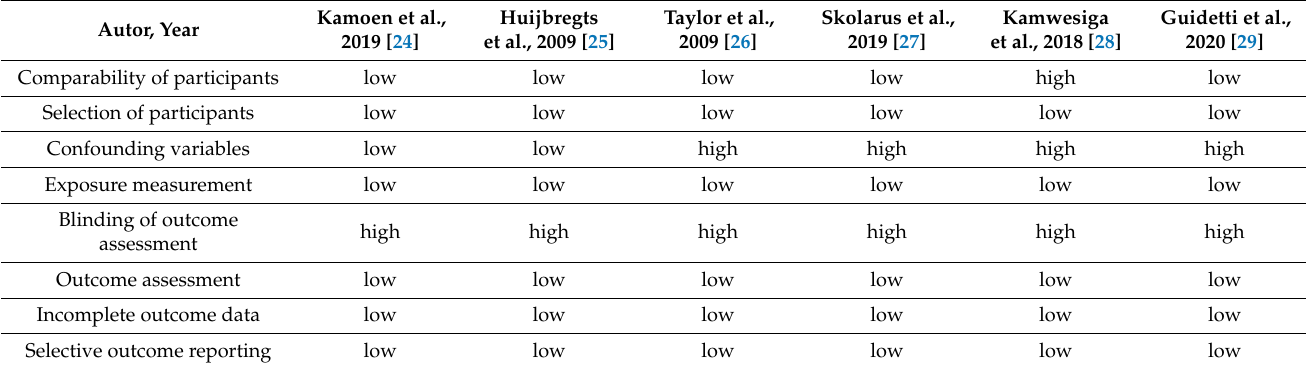
Table 2. Summarized results of the quality evaluation for NRCT literature using RoBANS.